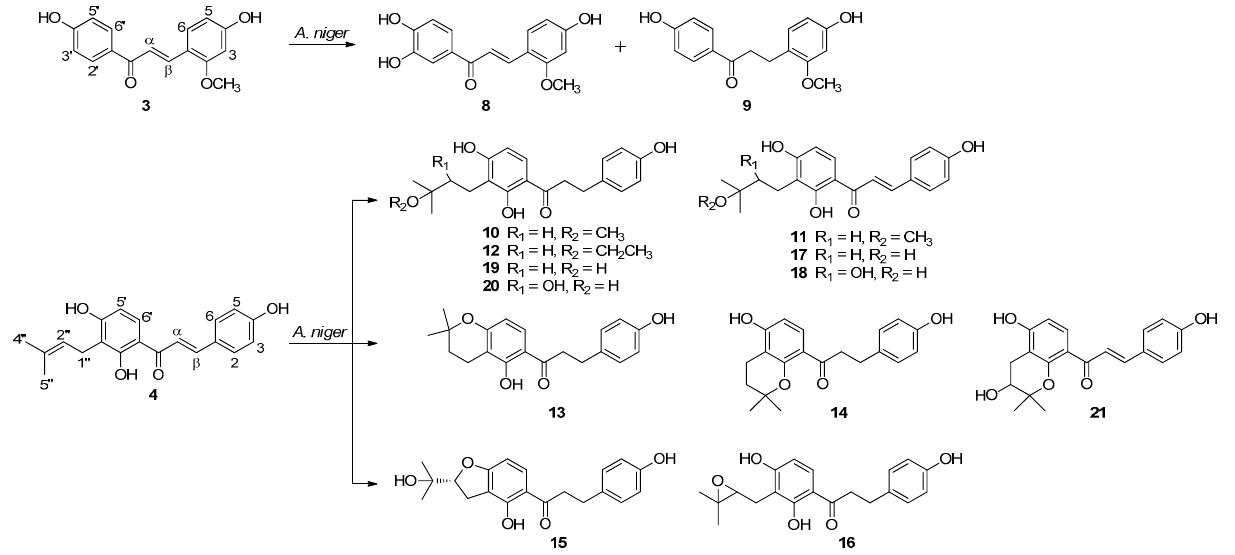
Figure 2. Compounds 8 – 21 obtained by biotransformation of 3 and 4 with A. niger .